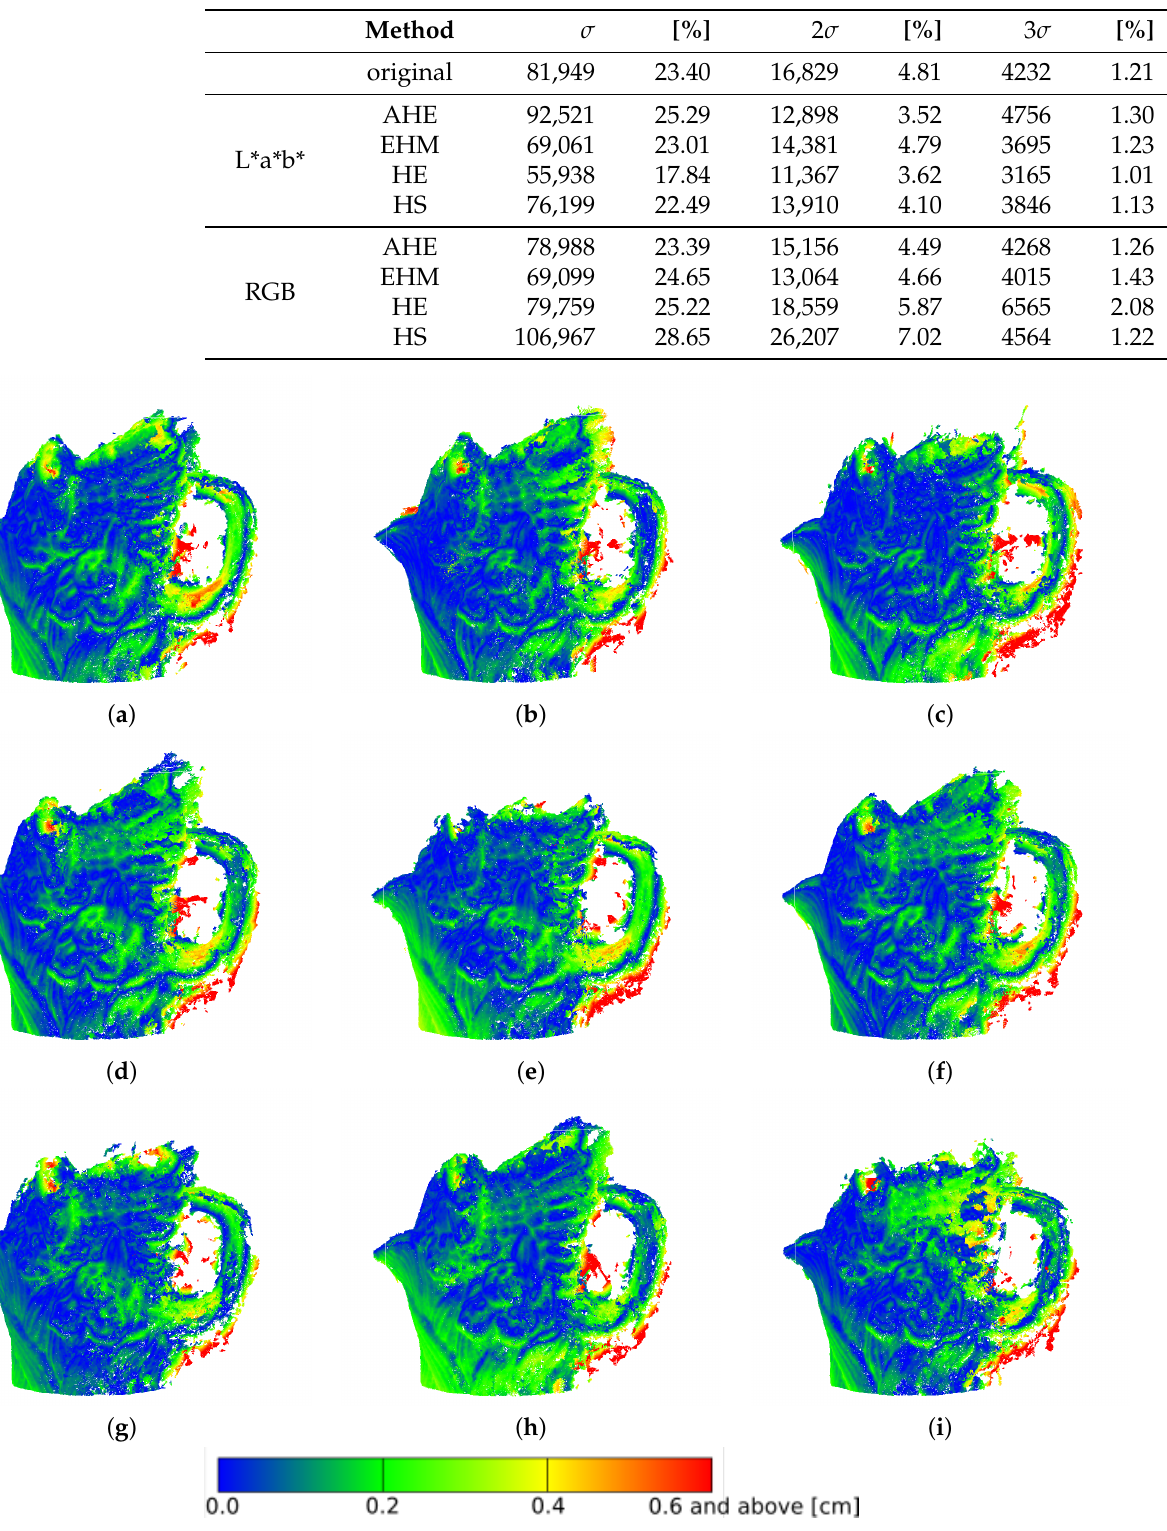
Table 2. Tail analysis for swan figure ( σ = Q 3 = 0.2).